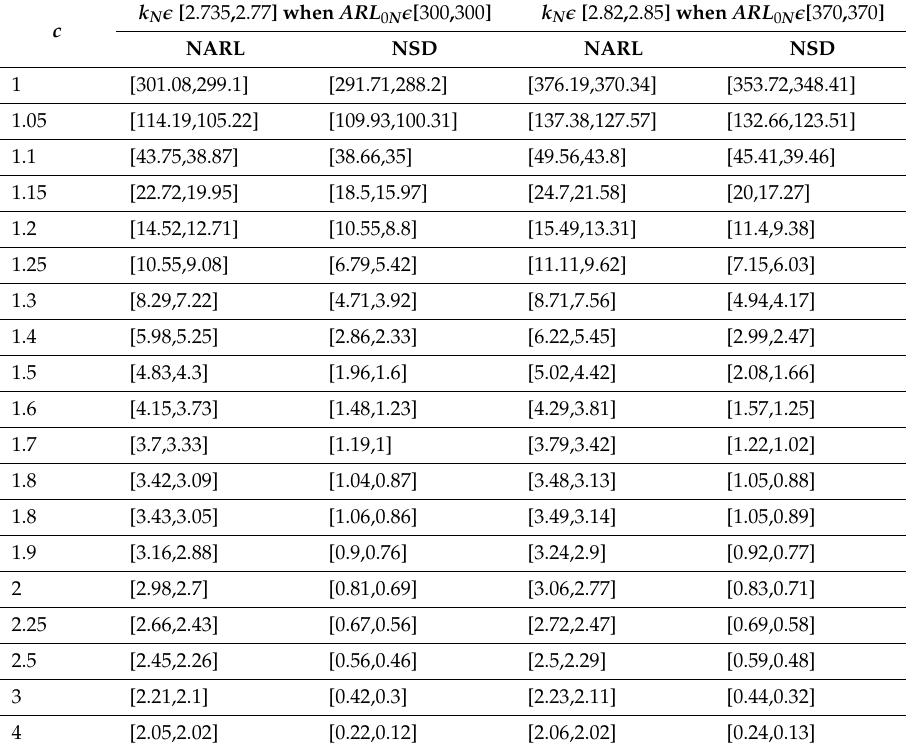
Table 6. The neutrosophic average run length (NARL) when n N (cid:15) [8, 10] and λ N (cid:15) [0.18,